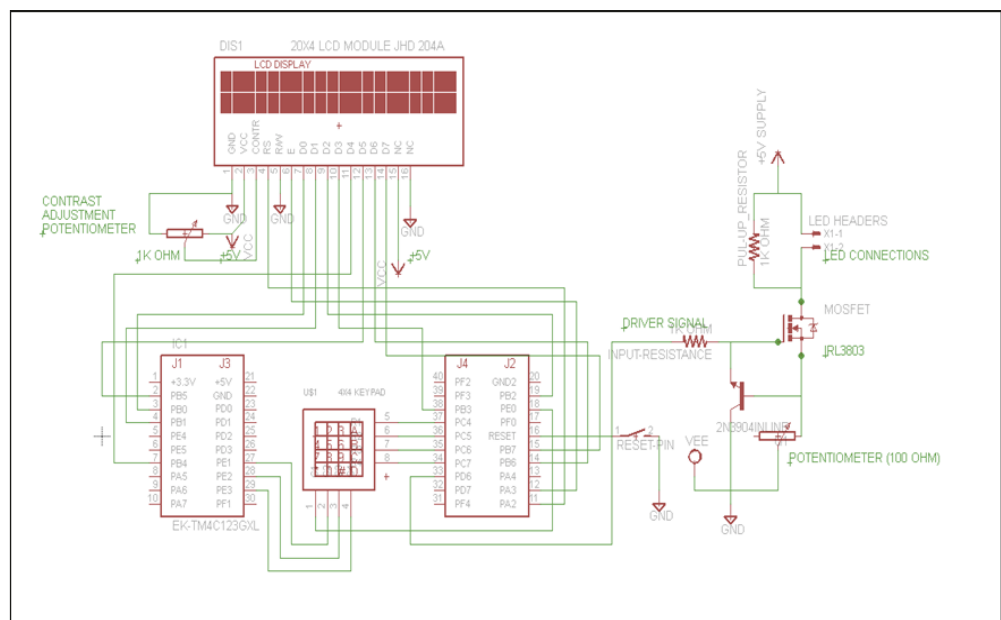
Figure 3: PCB schematic of the LED based phototherapy